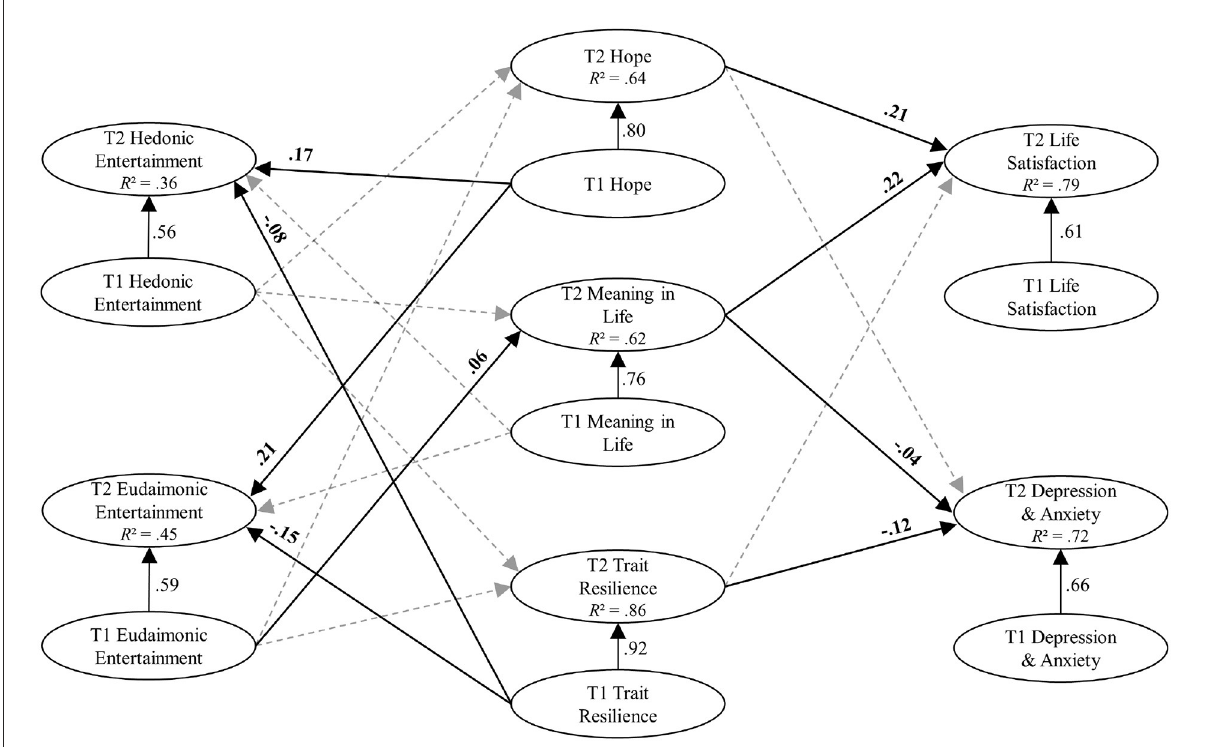
FIGURE1 Visualization of the final model. N = 2,561. Dashed gray arrows represent non-significant relationships. Black arrows with numbers represent significant ( p < 0.05) relationships. Depicted are unstandardized estimates of the structural equation model. Covariances, latent variables, and errors were omitted for